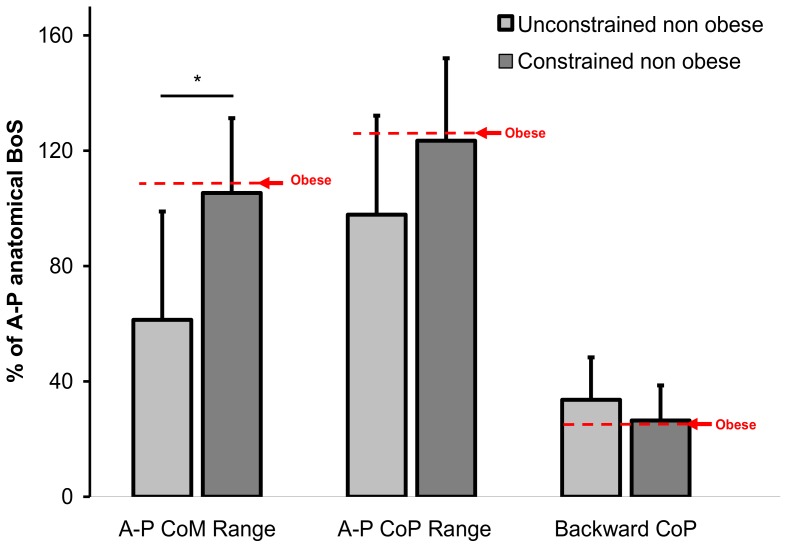
A-P CoP and CoM range displacement, as a percentage of the anatomical distance from the BoS for the descending + ascending movement for the non obese group with and without additional biomechanical constraints.